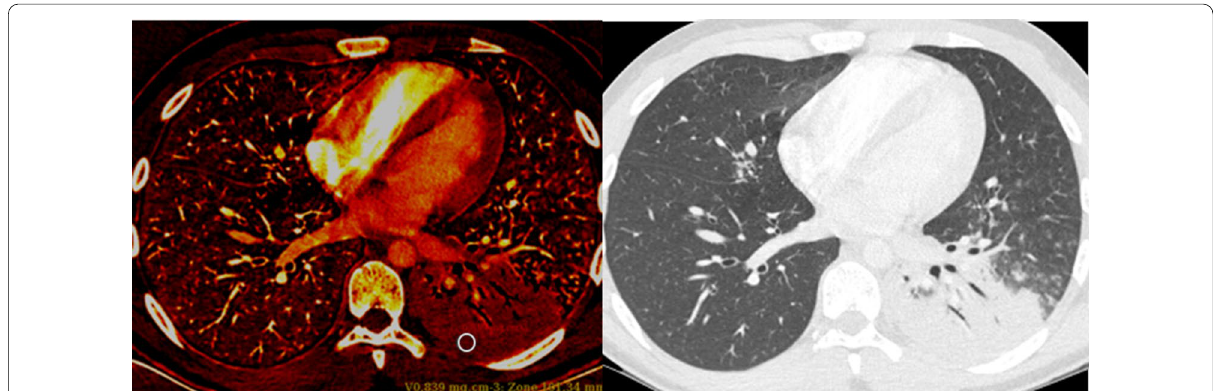
) is seen (iodine map, left) matching a left basal +